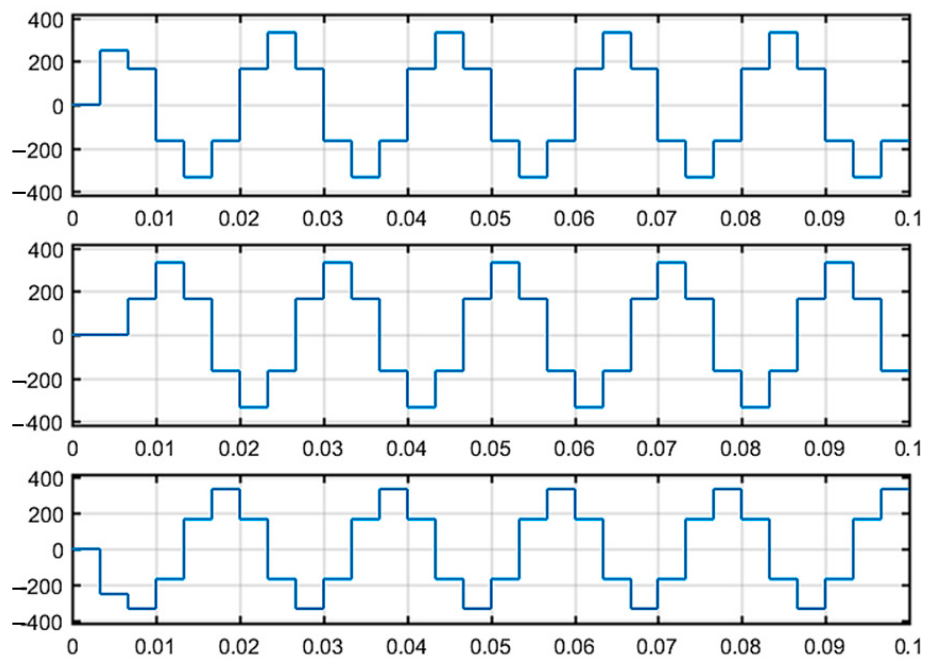
Figure 12. Phase voltage waveform at 180° [41].